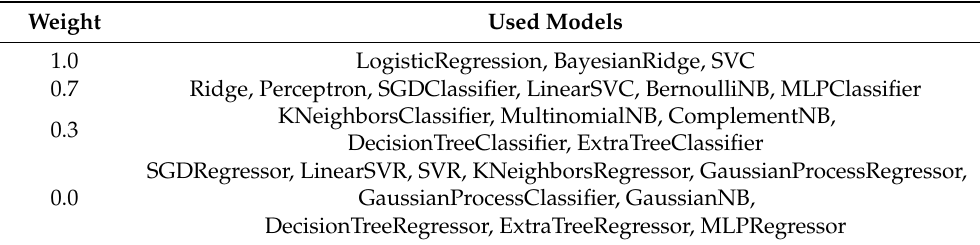
Table 1. Individual model weights contributing to the combined